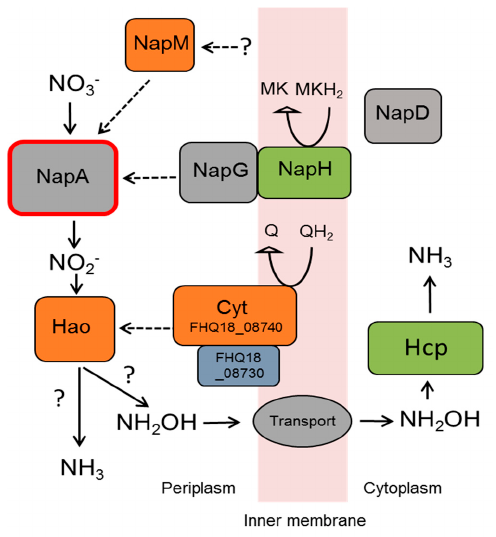
Figure 6. The putative enzymatic system of nitrate reduction to ammonium in D. autotrophicus . See explanations in the text.